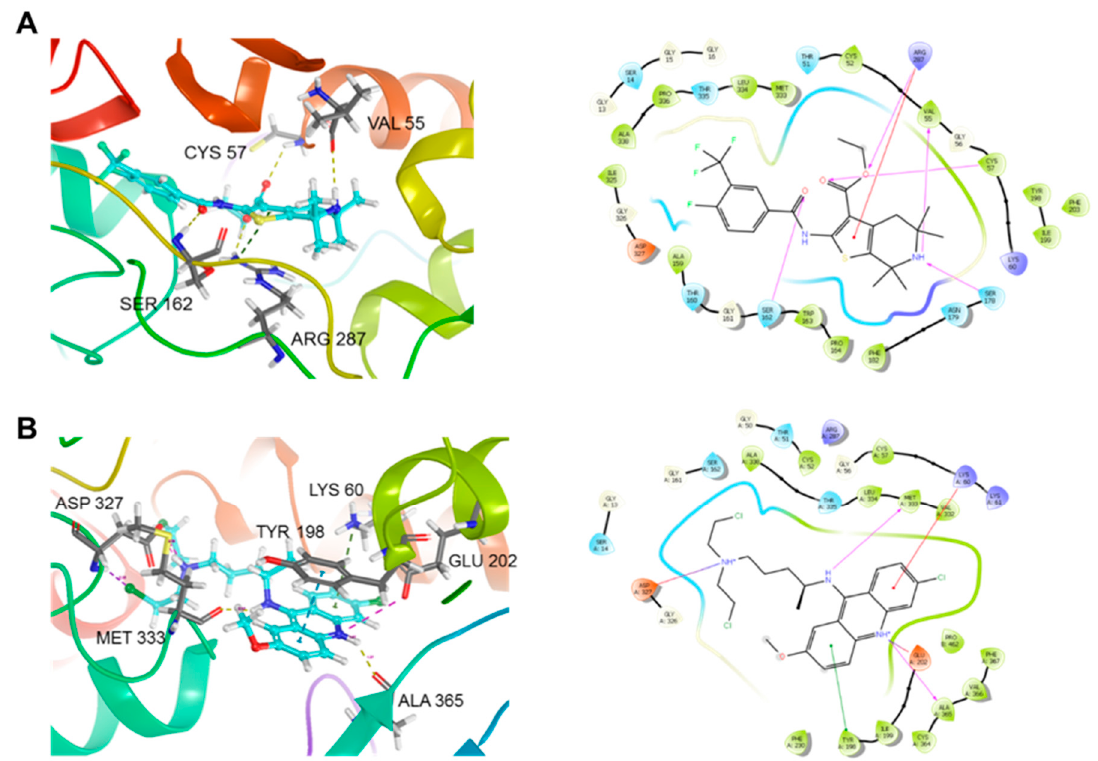
Figure 7. Trypanothione Reductase from L. infantum (PDB: 2JK6) Protein–ligand complex of Induced Fit Docking (IFD): ( A ) ligand interaction diagram of 5D in complex with 2JK6 and 2D ligand interaction and; ( B ) ligand interaction diagram of Quinacrine Mustard in complex with 2JK6 and 2D ligand interaction.